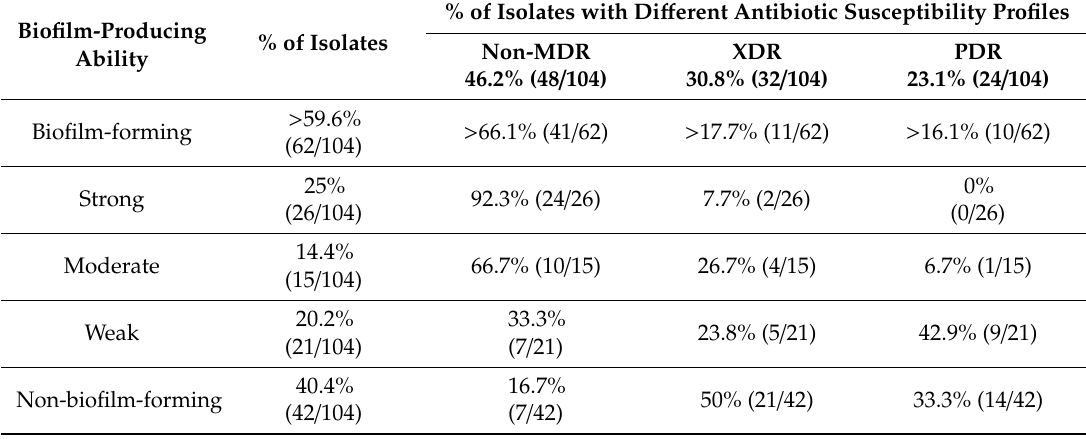
Table 3. The relationship among biofilm-producing ability of A. baumannii with antibiotic resistance.